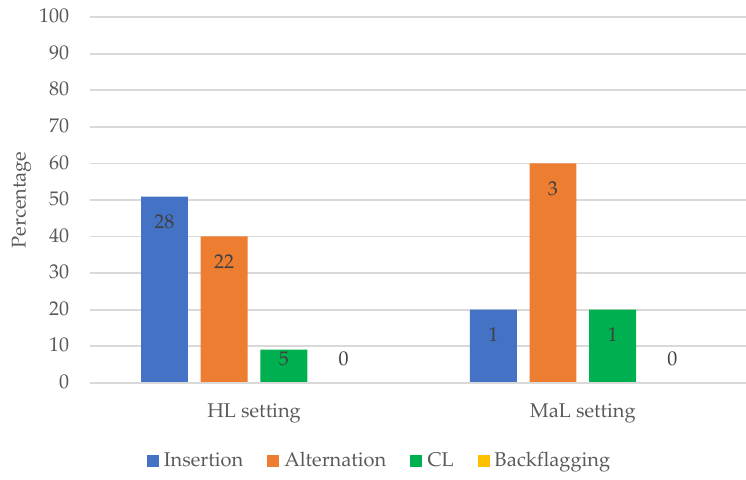
Figure 18. Four CS strategies and HL/MaL setting.